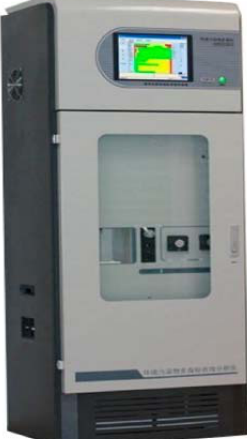
Figure 3. Photograph of the AOBS of Shi et al. modified. Reprinted with permission from [135]. Copyright 2013 American Chemical Society.